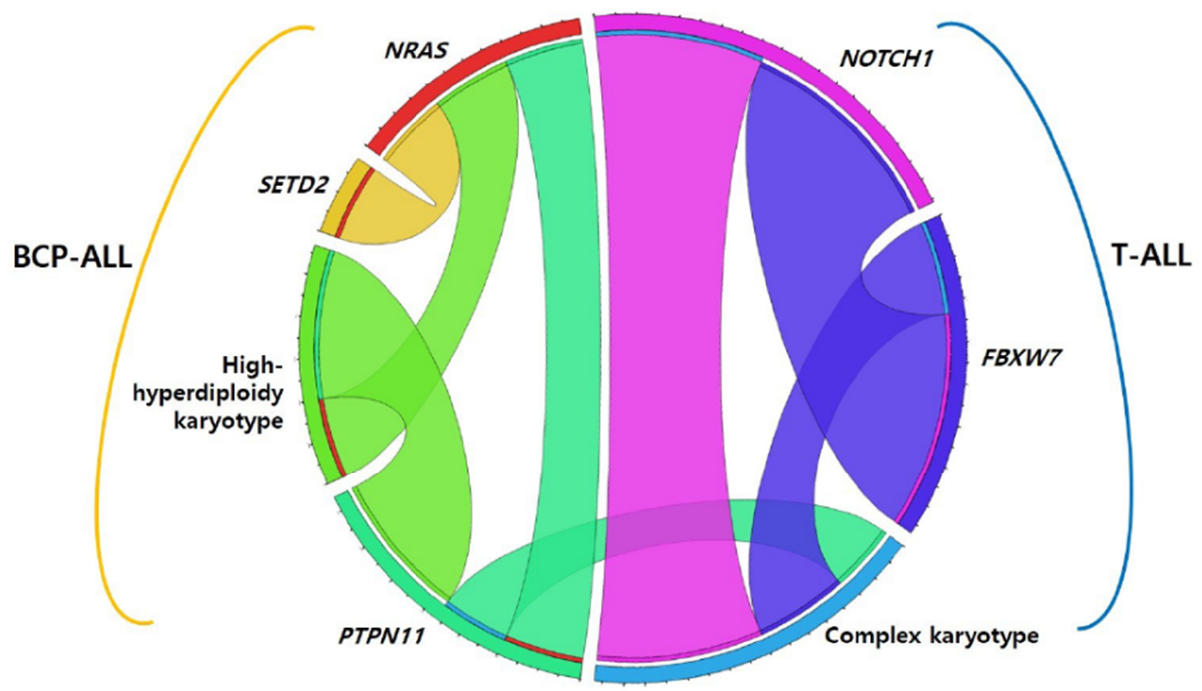
Figure 2. Co-occurring mutations in pediatric acute lymphoblastic leukemia. Abbreviation: BCP-ALL, B-cell precursor acute lymphoblastic leukemia.